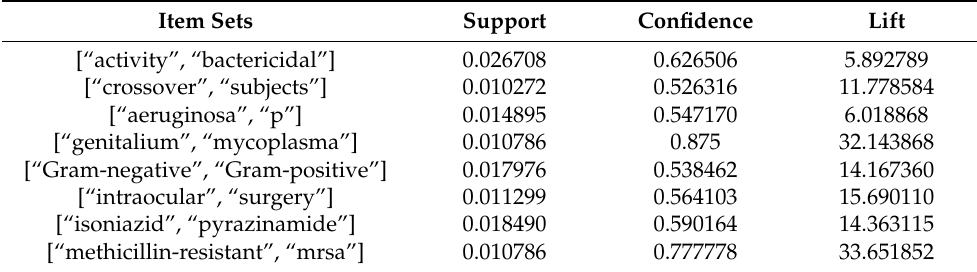
Table 2. Sample item sets of moxifloxacin dataset.